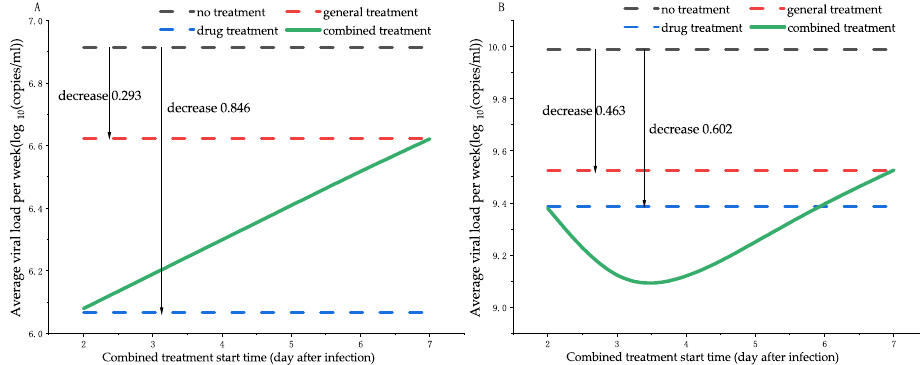
Figure 10. Relationship between the drug treatment start time and the average viral load in a week with combined treatment: ( A ) mild patients (the average viral load increased after delayed drug treatment); ( B ) severe patients (the average viral load decreased first and then increased with the onset of drug